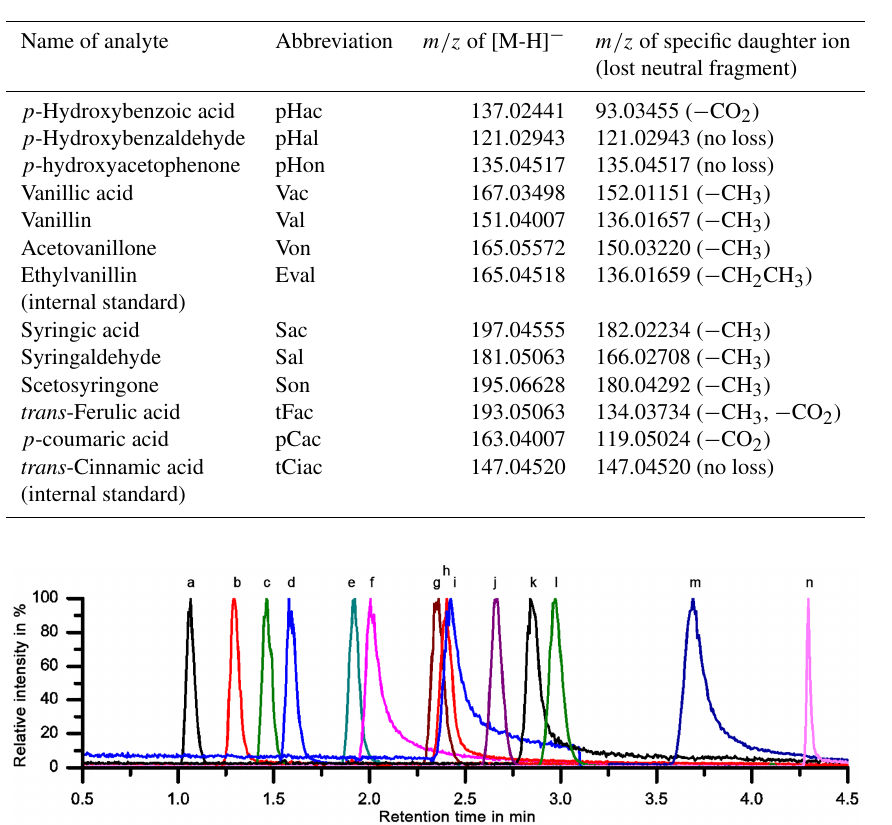
Table 1. Names and abbreviations of the analytes with the respective m/z values of their deprotonated molecular ions [M-H] − and their specific daughter ions.